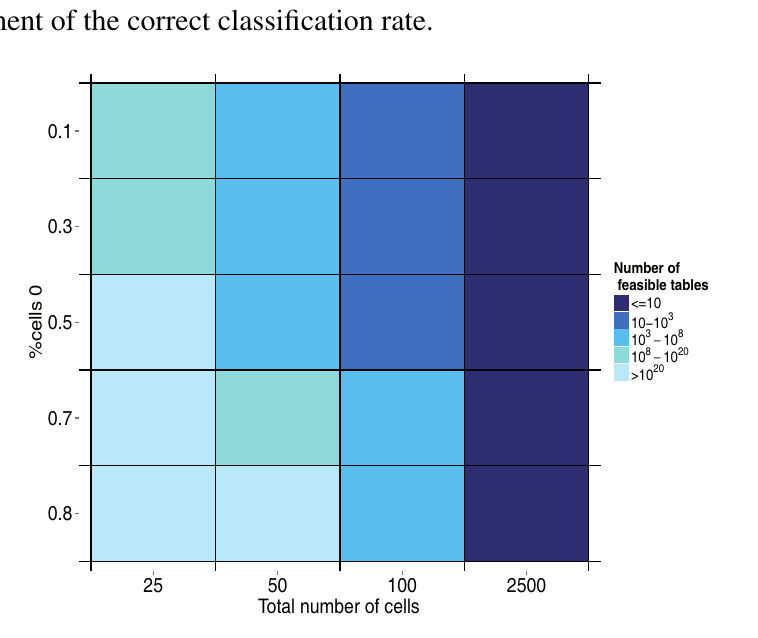
Figure 3. Number of feasible tables per round, depending on % of cells of zero and the total number of cells.